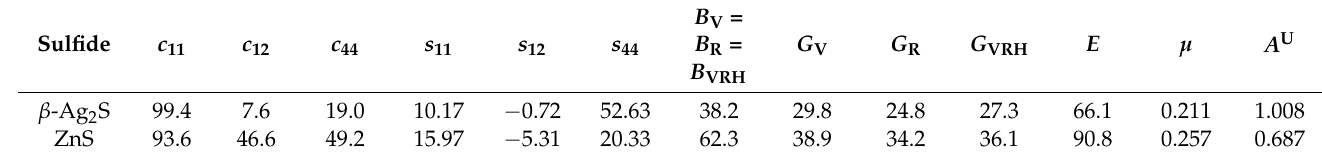
Table 5. Elastic stiffness constants c ij (GPa), elastic compliance constants s ij (10 − 12 Pa − 1 ), bulk B , shear G , and the Young’s E moduli (GPa), the Poisson’s ratios µ and the universal anisotropy criterion A U for cubic β -Ag 2 S (space group Im 3 m ) and ZnS (space group F 43 m ) sulfides at a temperature of 300